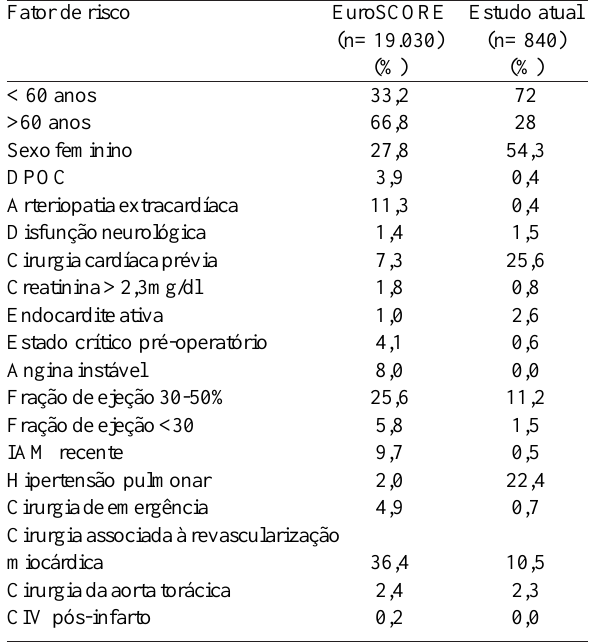
Tabela 2. Prevalência dos fatores de risco no estudo original e em nosso estudo.